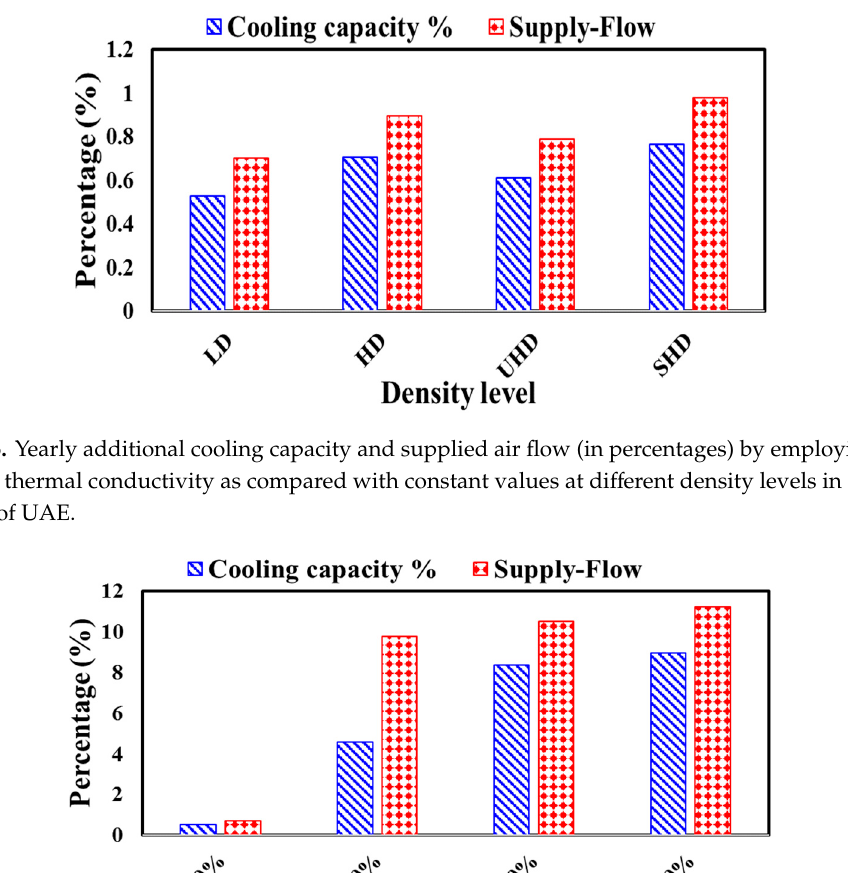
Figure 5. Yearly average and peak additional space cooling percentages employing dry variable thermal conductivity as compared with constant value at different moisture levels in the hot climate of UAE.